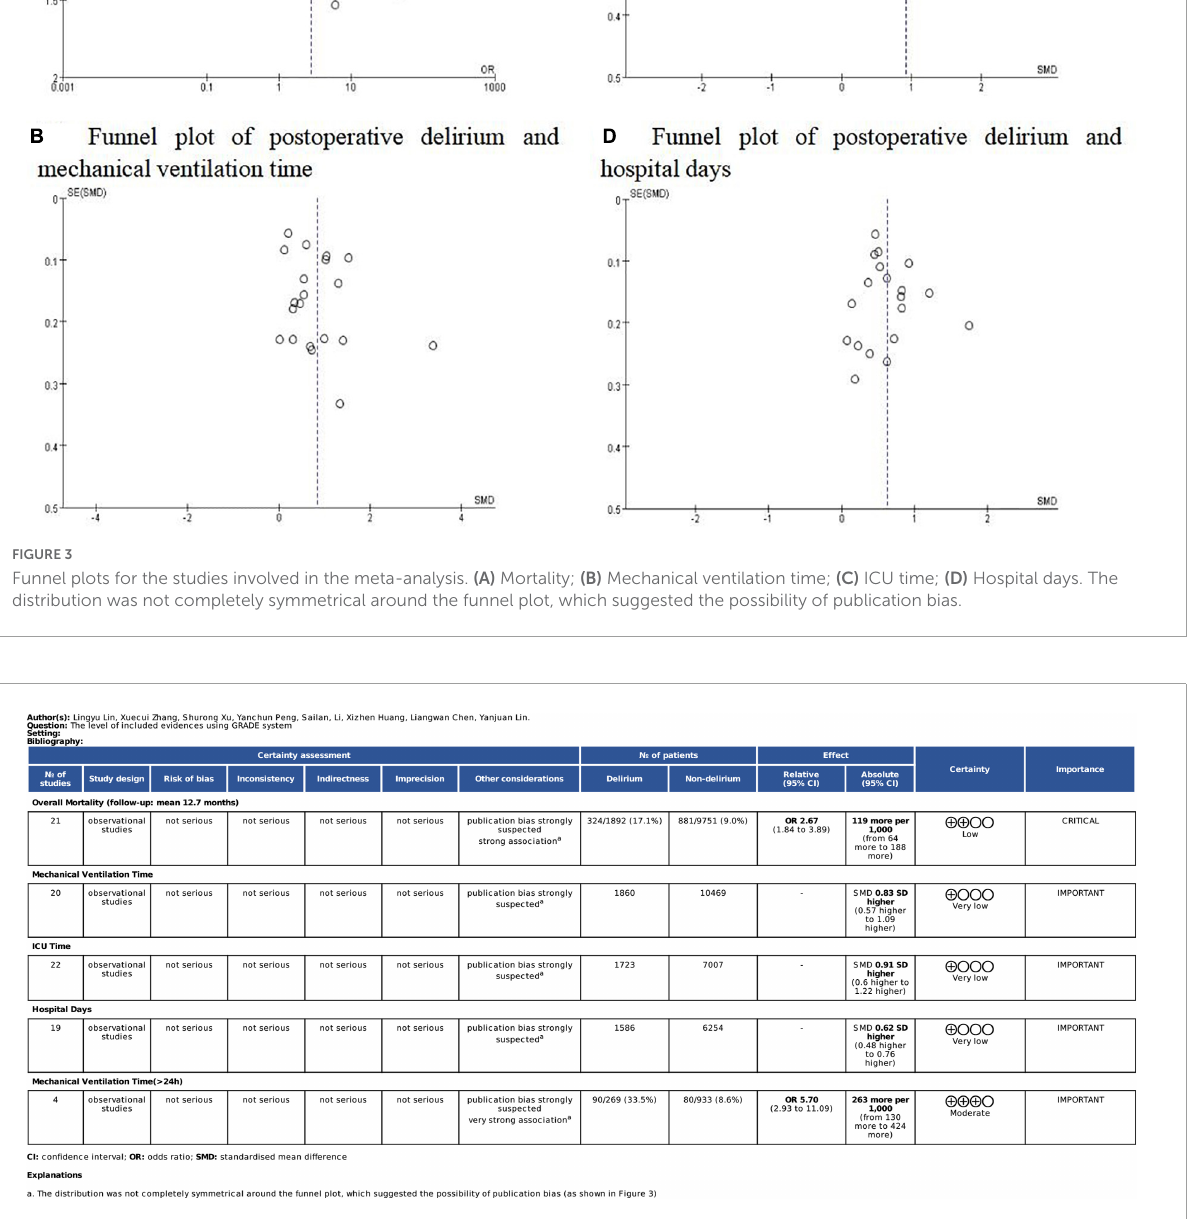
FIGURE4 Grading of recommendations, assessment, development and evaluation (GRADE) summary of findings